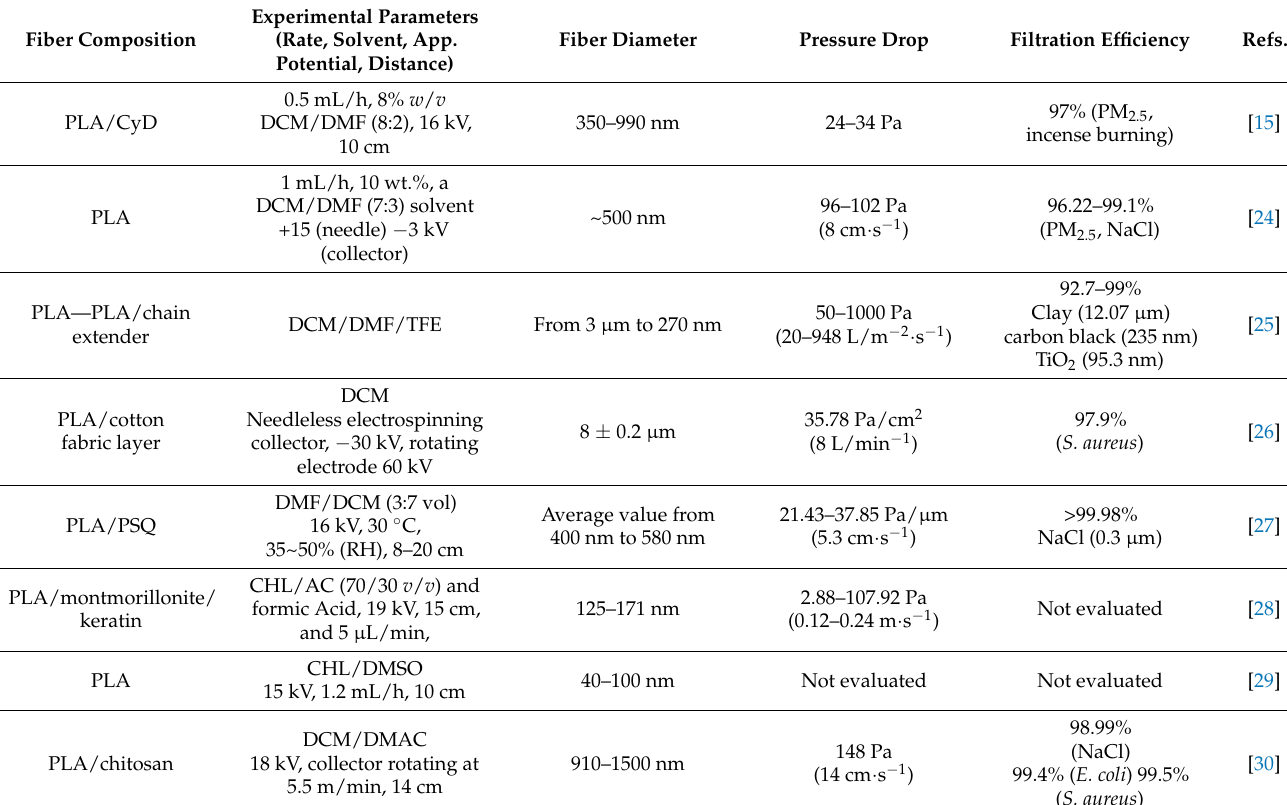
Table 1. Brief literature review of PLA-based electrospun